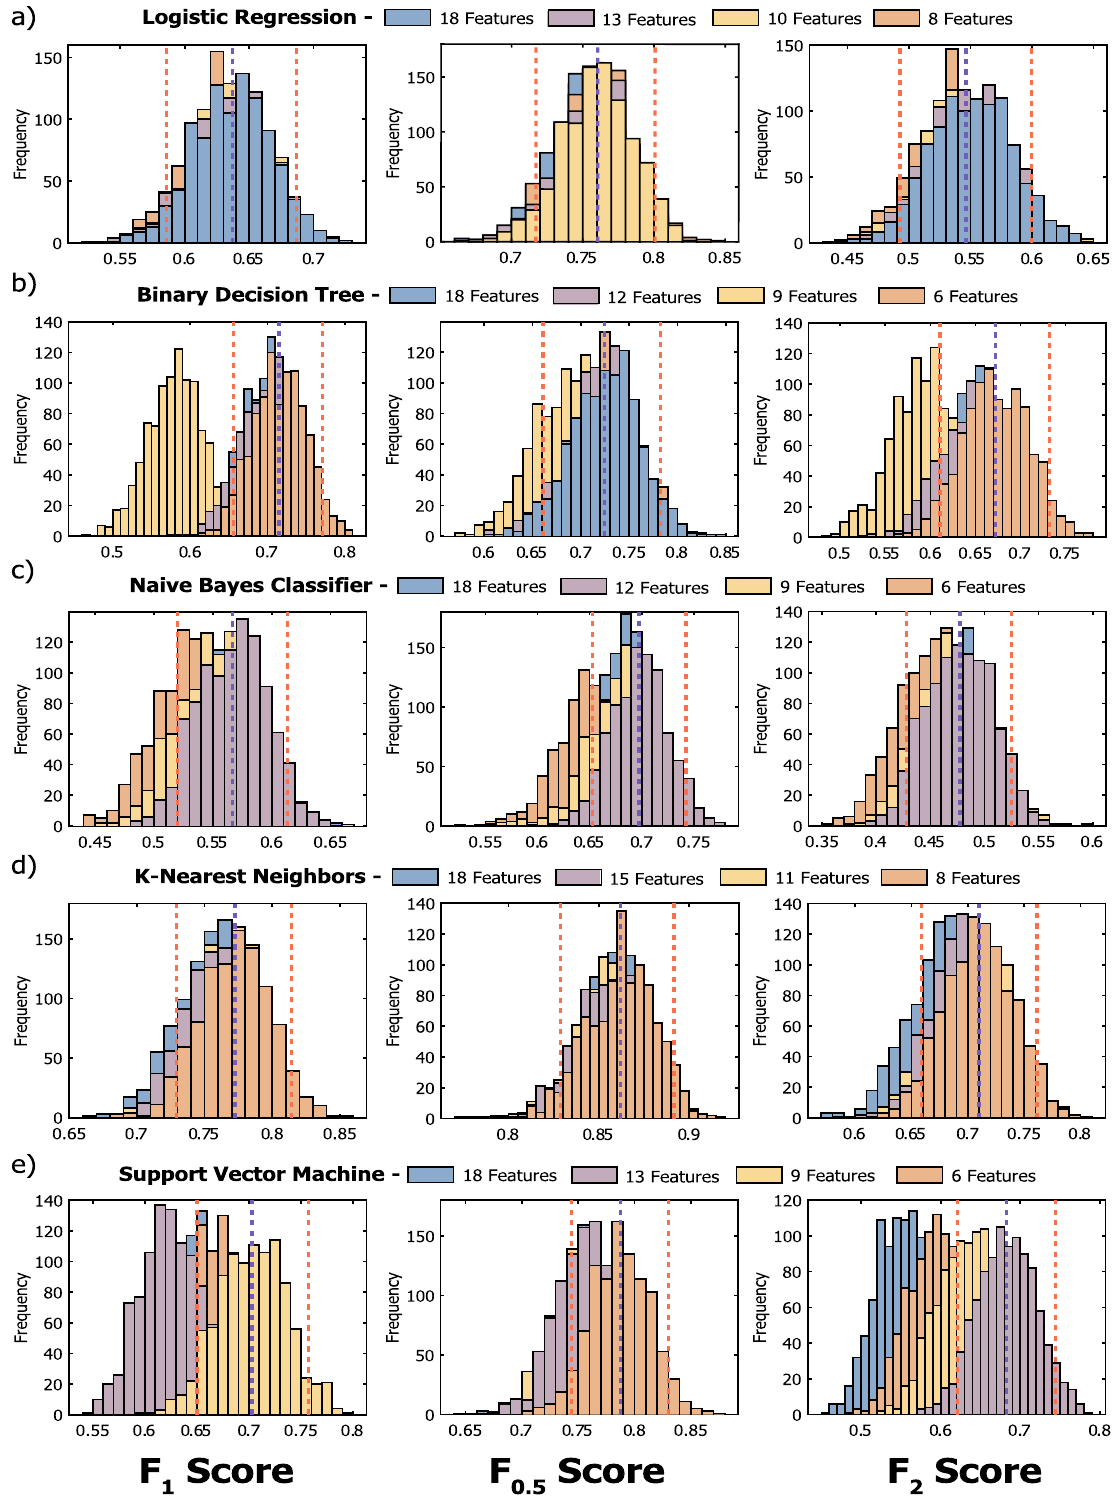
Figure 7. Bootstrapping validation F β -scores for β = 1, 0.5 and 2 for 10,000 round of validation for LR ( a ), DT ( b ), NBC ( c ), KNN ( d ) and SVM ( e ). Each number of feature validation performance is presented, together with the median F β -score (red dashed line) and lower and upper confidence interval (95%, blue dashed line) for the best